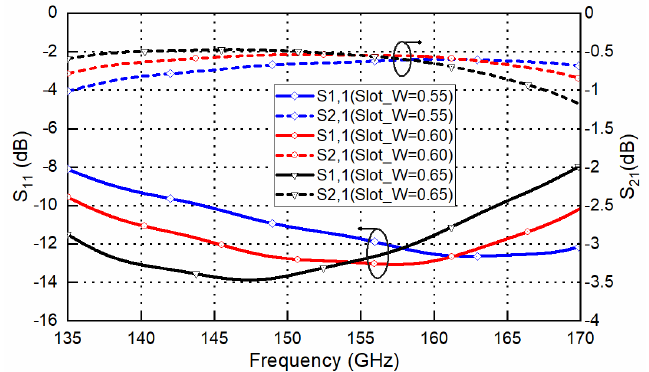
( b ) Figure 7. Substrateless transition. ( a ) E-field distribution of the transition; ( b ) simulated perfor- mances of the transition. Usually, CNC milling machines are used for the waveguide and leak proof cover. WEDM-LS are used to machine high-precision deep holes with small diameters for the upper layer’s EBG hole. Some parameter studies for the proposed transition (focused on 135–170 GHz for acceptable return loss) are presented in this section. This parameter study could be used for the design and sensitivity analysis of the transition. Figure 8 shows the effects of the slot width ( slot_W ) on the frequency response of the transition. It can be seen that the frequency response shifts towards lower frequencies when the width increases from 0.55 mm to 0.65 mm. The transition loss is below 1 dB and shows insuscep- tibility with the slot width. Figure 9 shows the effects of the slot length ( slot_L ) on the frequency response of the transition. It can be seen that the frequency response shifts to- wards lower frequencies when the length increases from 1.1 mm to 1.3 mm, while the 10 dB return-loss bandwidth remains basically unchanged. Using a high-precision wedge– wedge wire bonder, the minimum value of the wire arc height H w is 20 μ m. Under ultra- low H w conditions, the distance between the two bonding pads D could be less than 150